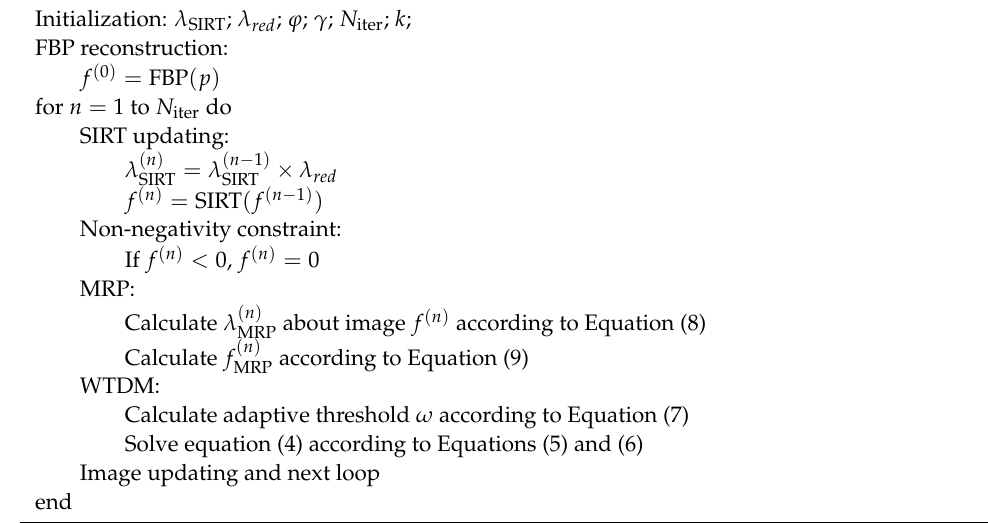
Algorithm 1. The organizational scheme of the